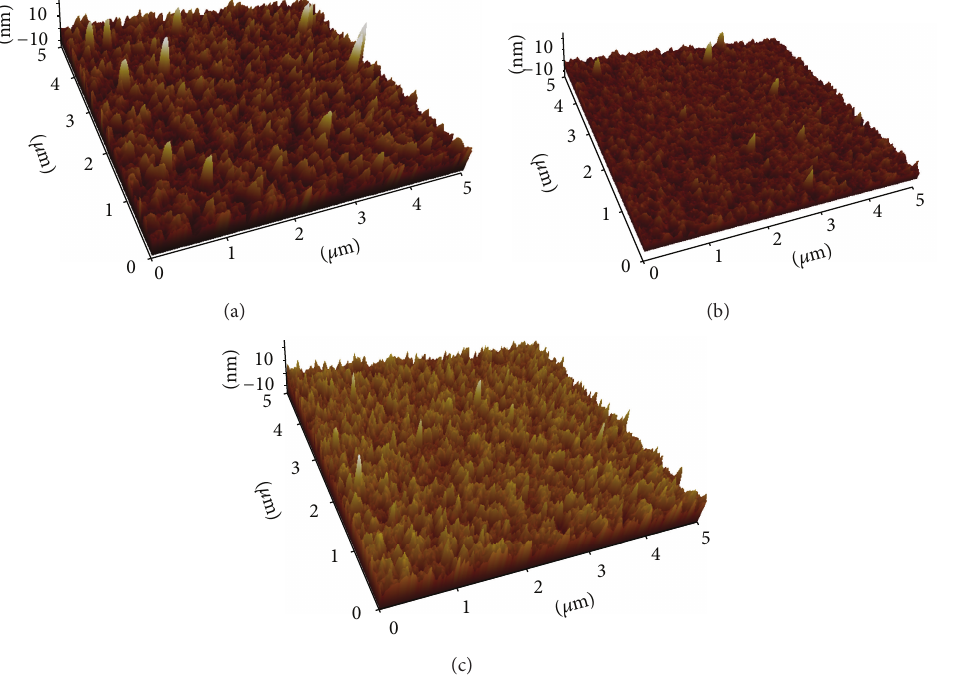
Figure 4: The surface morphologies of (a) bare ITO, (b) ITO/PEDOT: PSS, and (c) ITO/MoO 3 .